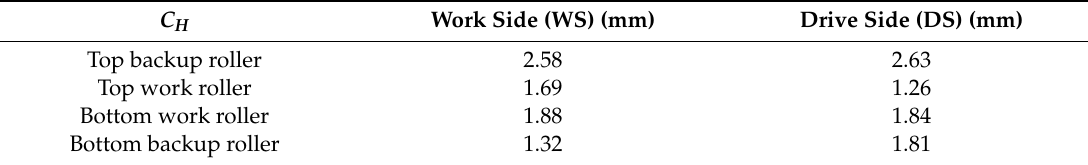
Figure 5. Clearance modeling using connector elements. ( a ) horizontal clearance, ( b ) axial clearance. Table 3. On-site clearances C H in a finishing mill in China Steel Corporation (CSC) Kaohsiung.